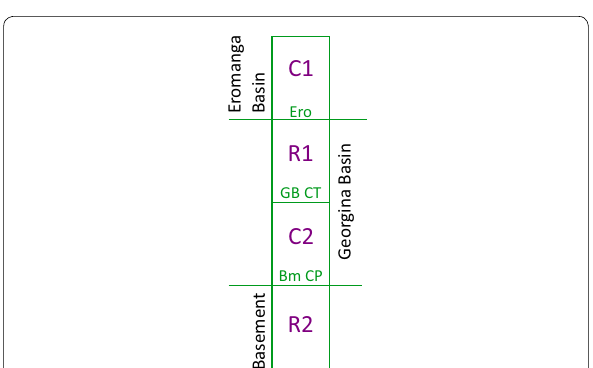
Fig. 9 Schematic summary of interpretation. Labelled features from 2D inversion are indicated in purple and picked interfaces based on 1D inversions are indicated in green. Macroscale geological subdivisions are indicated in black